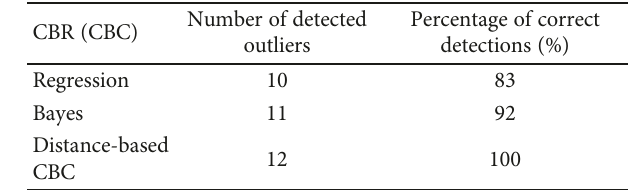
Table 4: Measures of rating distance-based reasoning. Distance-